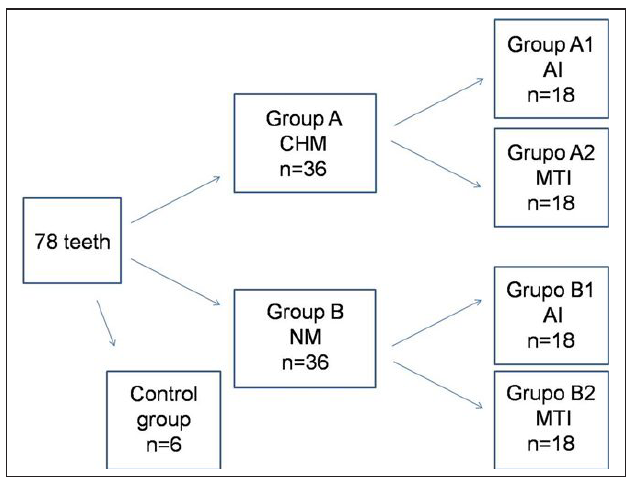
Fig. 2- Experimental groups: A – calcium hydroxide-medicated group (CHM), B – non-medicated group (NM), A1 and B1 – apical leakage groups (AI), A2 and B2 middle third leakage groups (MTI).